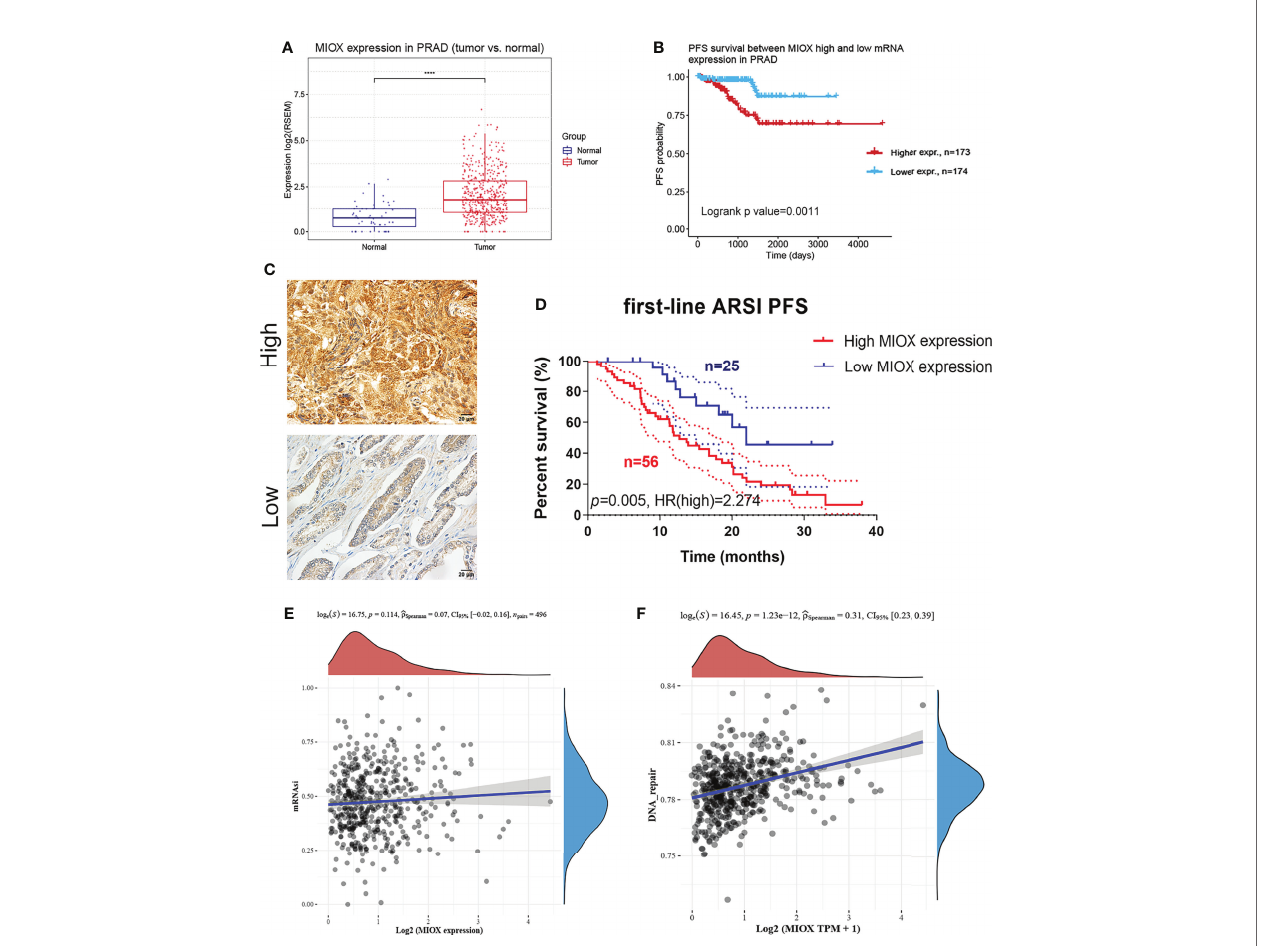
FIGURE 6 | Differential myo-inositol oxygenase (MIOX) expression predicts outcomes in 81 prostate adenocarcinoma (PRAD) patients from Renji cohorts. (A) MIOX was expressed at lower levels in normal prostate tissues. (B) In PRAD samples from The Cancer Genome Atlas (TCGA) cohort, higher MIOX expression was associated with worse progression-free survival (PFS) in patients. (C, D) High MIOX expression was signi fi cantly correlated with poor prognosis (p = 0.005, HR = 2.274) in 81 PRAD patients from the Renji cohort. (E, F) Dryness Index Score for MIOX in